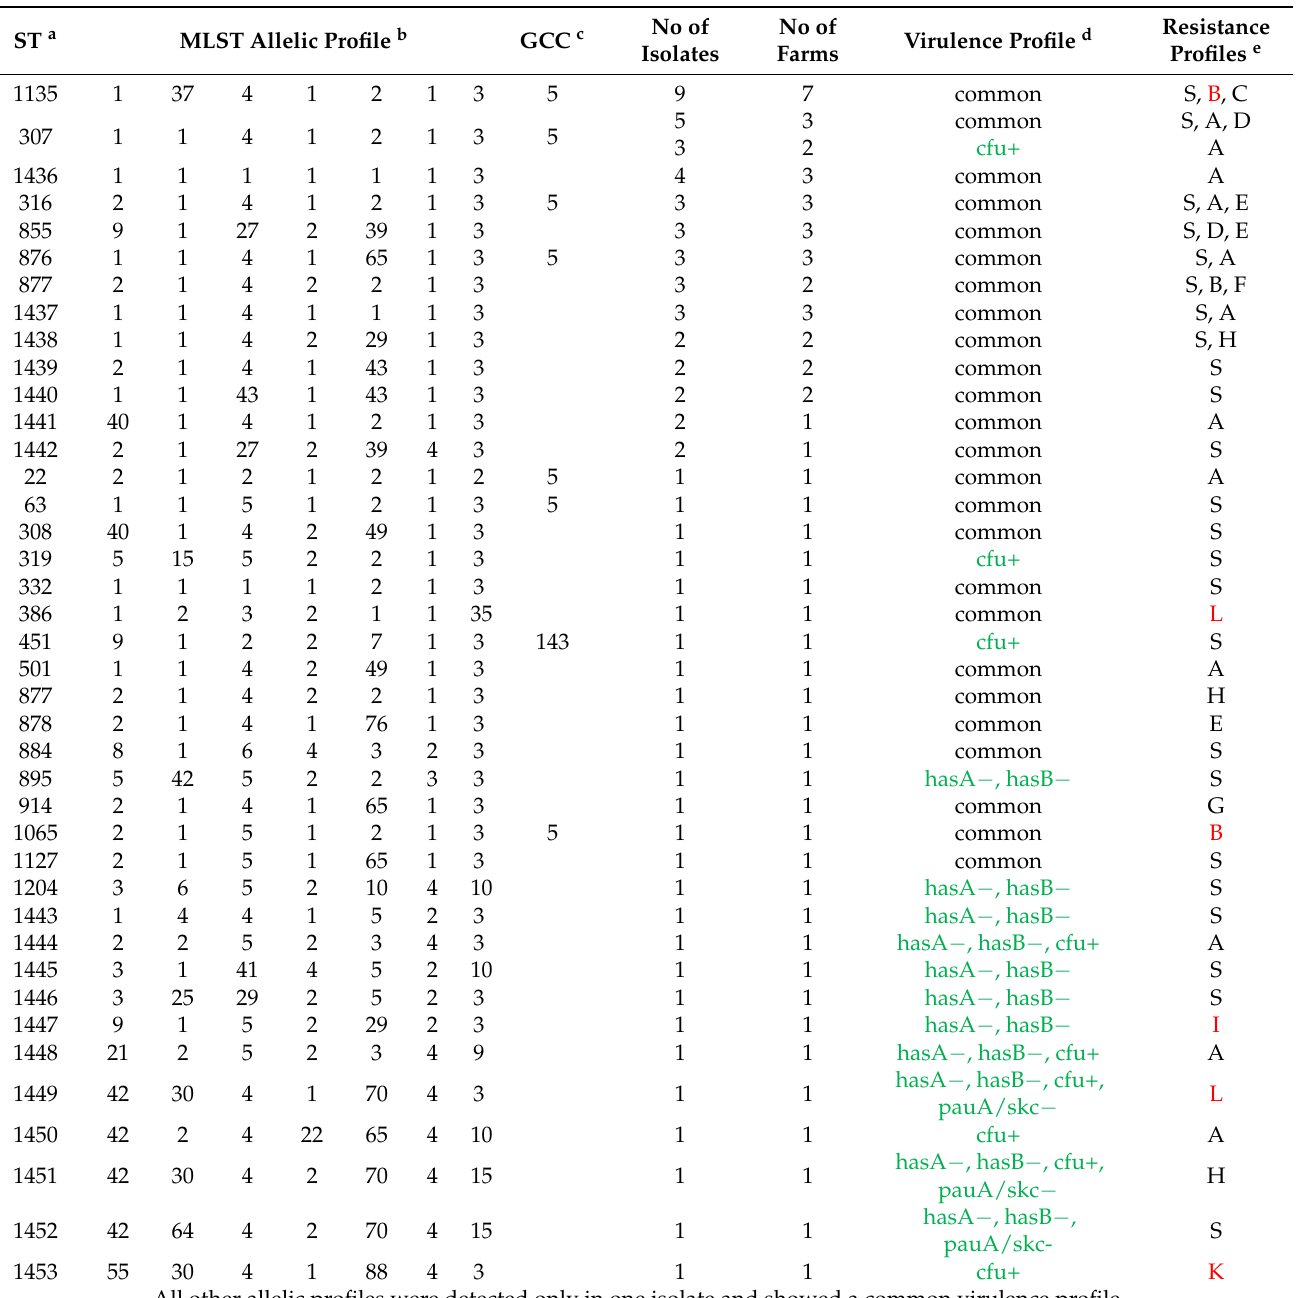
Table 2. Characterisation of 124 Streptococcus uberis isolates—distribution of sequence types and allelic profiles, virulence profiles, resistance profiles, frequency of